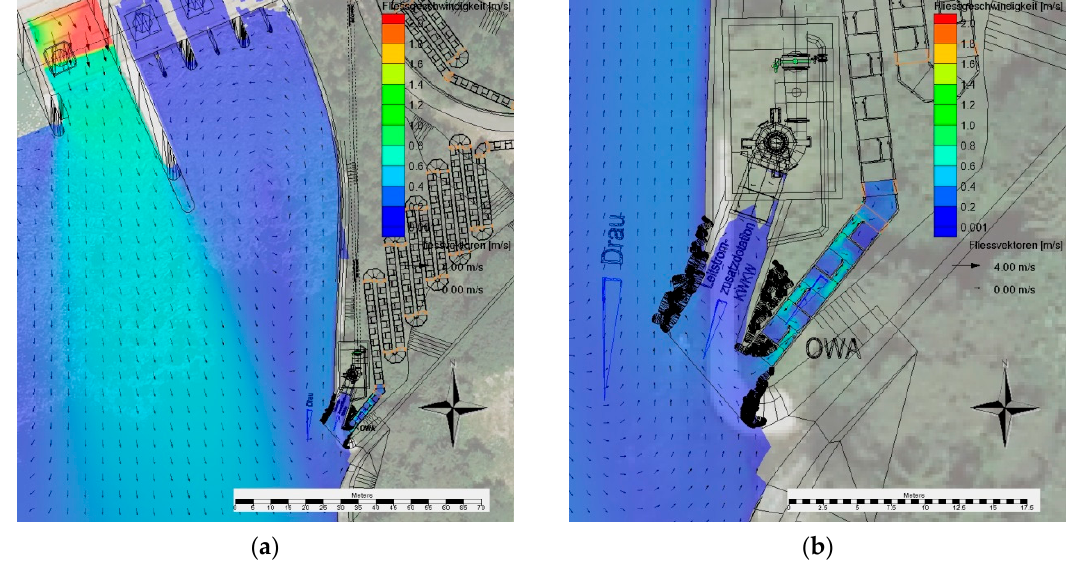
Figure 9. Alternative 4, result overview (a) and detail at entrance (b) of the 2D model. Q Drava = 80 m³/s, Q fish pass = 0.38 m³/s + Q attraction flow = 0.42 m³/s; competing flow 1%.